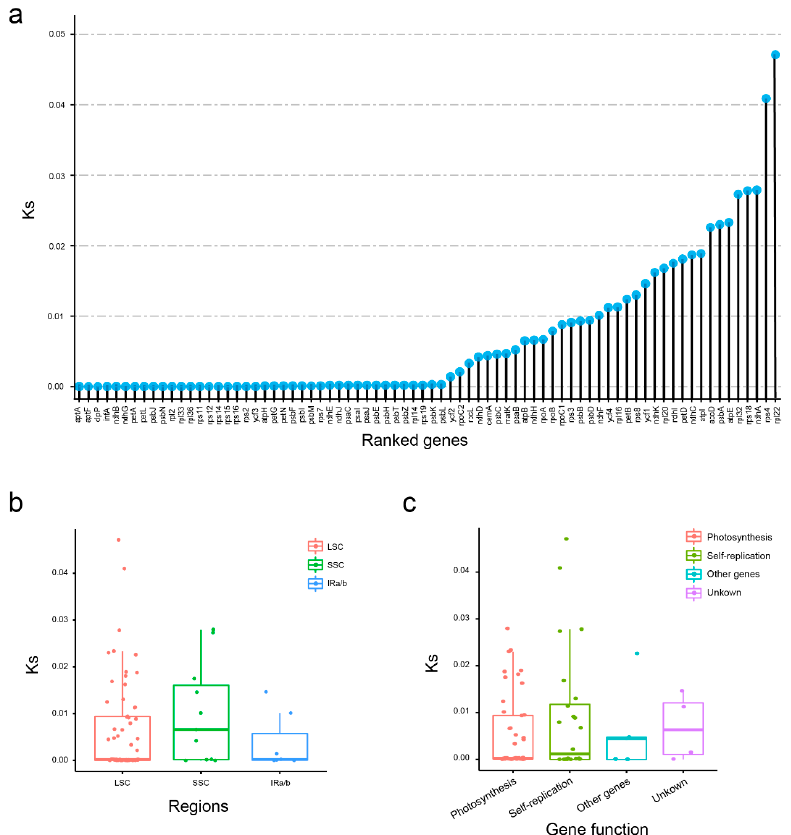
Figure 5. Compositions of Ks values of 76 protein coding genes in 12 Dianthus chloroplast genomes. ( a ) Ks values of 76 protein coding genes ranked by Ks. ( b ) Ks values in LSC/SSC/IR regions. ( c ) Ks values in genes with different functional classification.